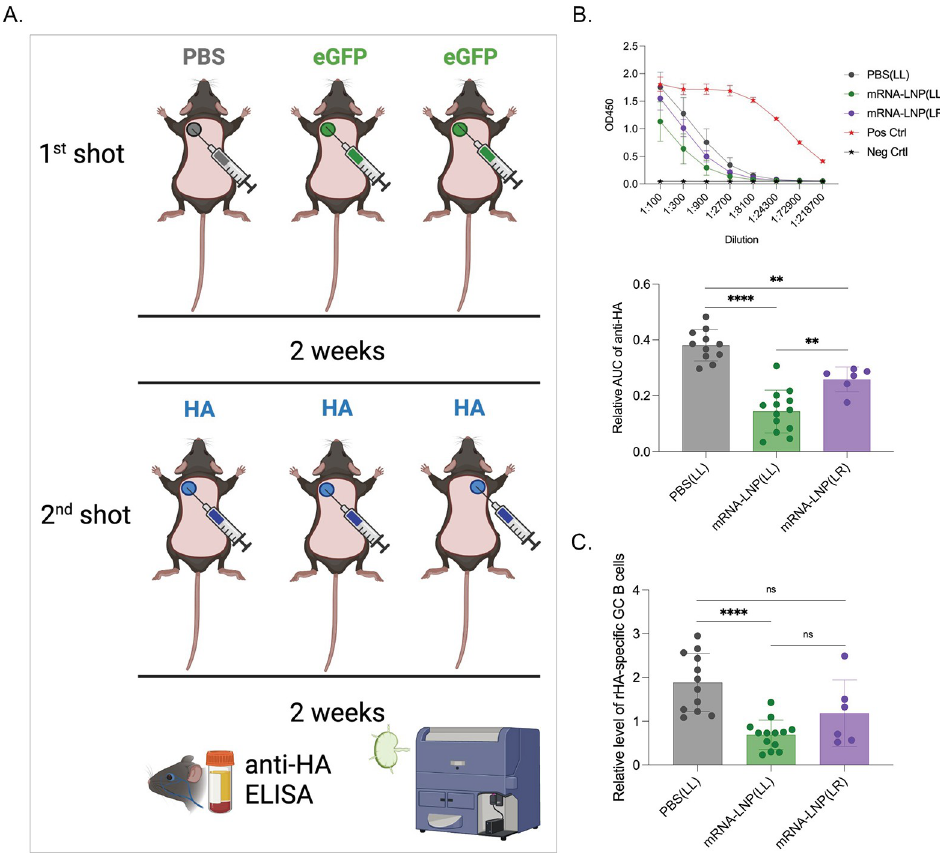
Fig 2. Pre-exposure to mRNA-LNPs has systemic effects. A ). Experimental model. As in Fig 1, but one of the groups was injected at a spot distinct from the primary exposure. B ). ELISA OD450 readings and summary AUC graph on serum anti-HA antibody levels. C ). Relative GC B cell responses from the same mice. Each dot represents a separate mouse. Data from at least two separate experiments pooled and are shown as mean ± SD. One-way ANOVA was used to establish significance. ns = not significant. � p < 0.05, �� p < 0.01, ���� p < 0.0001. Figures were drawn by the authors using